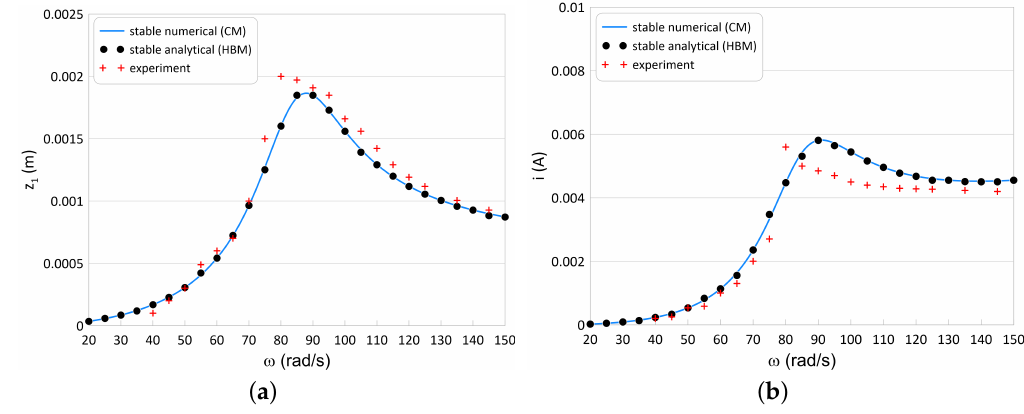
Figure 12. Magnet’s resonance curve ( a ) and the recovered current ( b ) for R = 2 k Ω and α = 70 V/A. The marked black points denote the HBM results, the blue lines mean numerical results and the plus signs are experimental